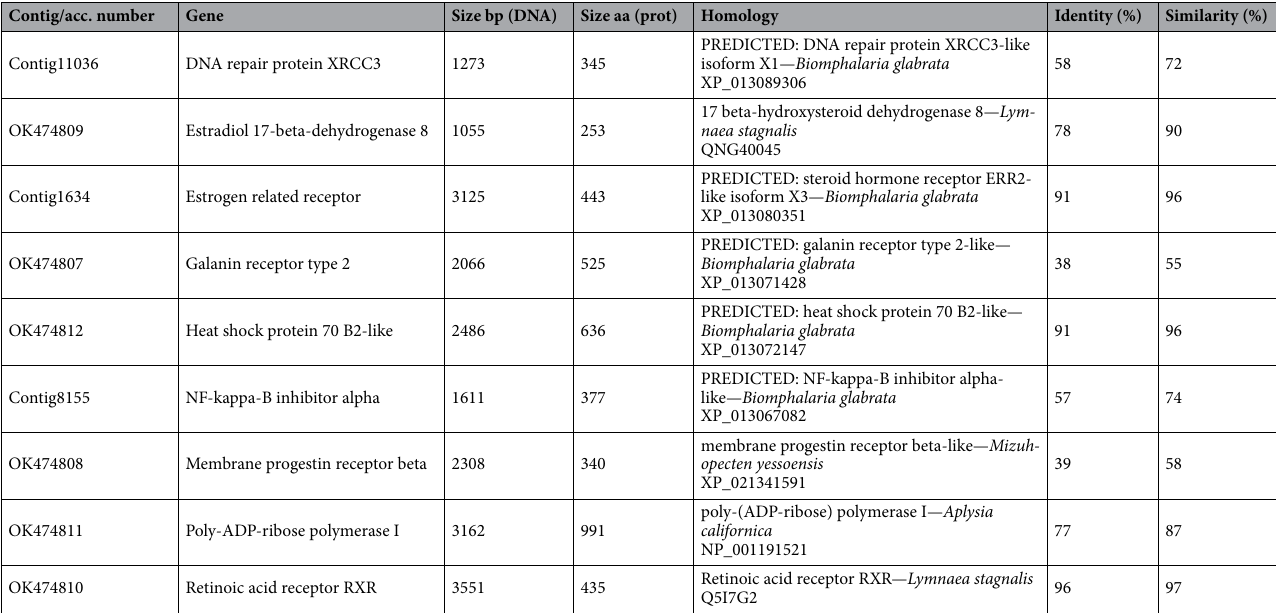
Table 1. Information of the sequences described for first time. DNA and protein size, homology, identity, and similarity are indicated. The contig number or accession number are indicated.